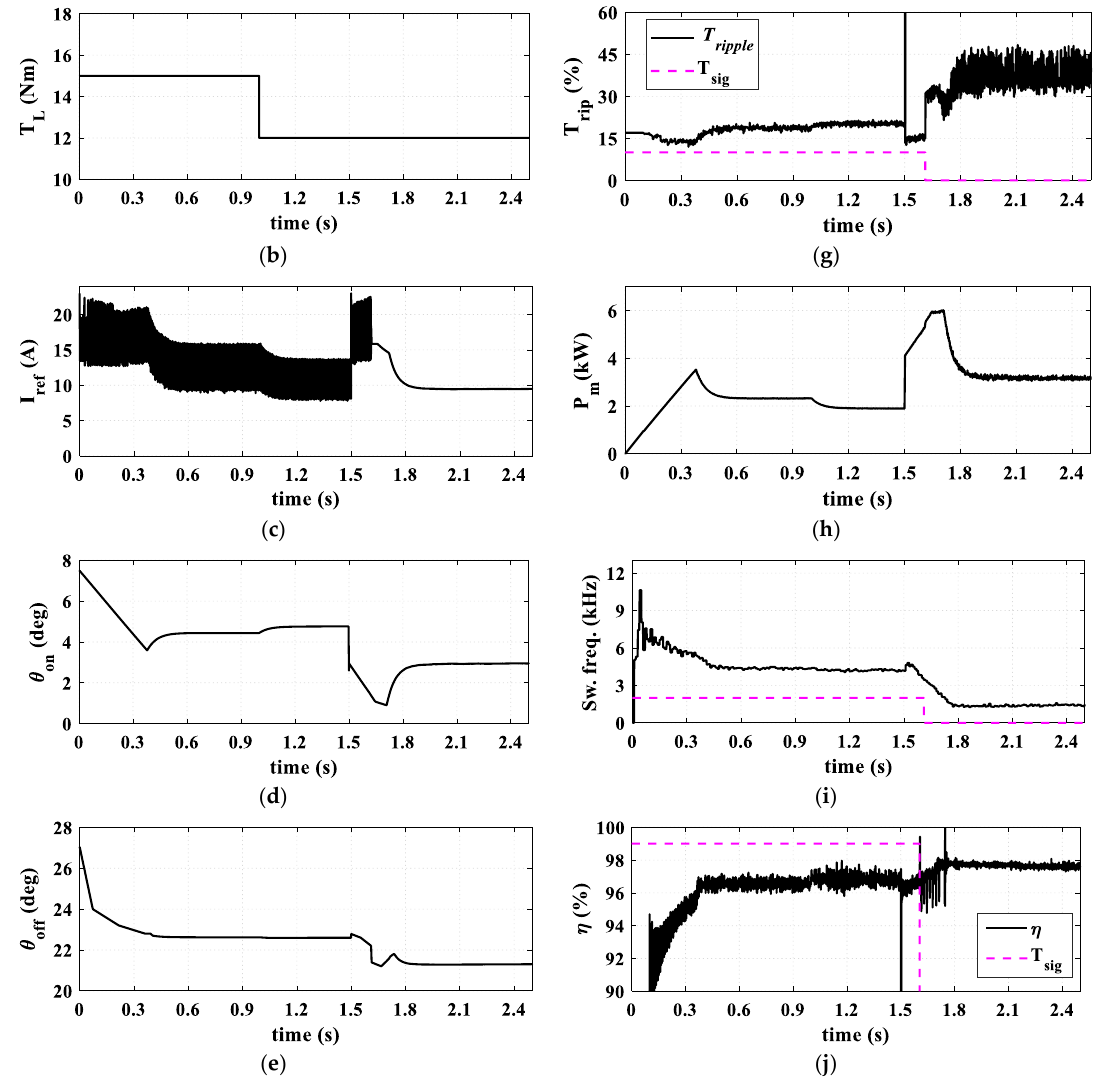
Figure 12. The simulation results under a sudden change in motor speed. ( a ) The motor speed; ( b ) the load torque; ( c ) the reference current; ( d ) the variation of the turn on angle; ( e ) the variation of the turn off angle; ( f ) the total electromagnetic torque; ( g ) the torque ripple; ( h ) the mechanical output power; ( i ) the switching frequency; ( j ) the efficiency.